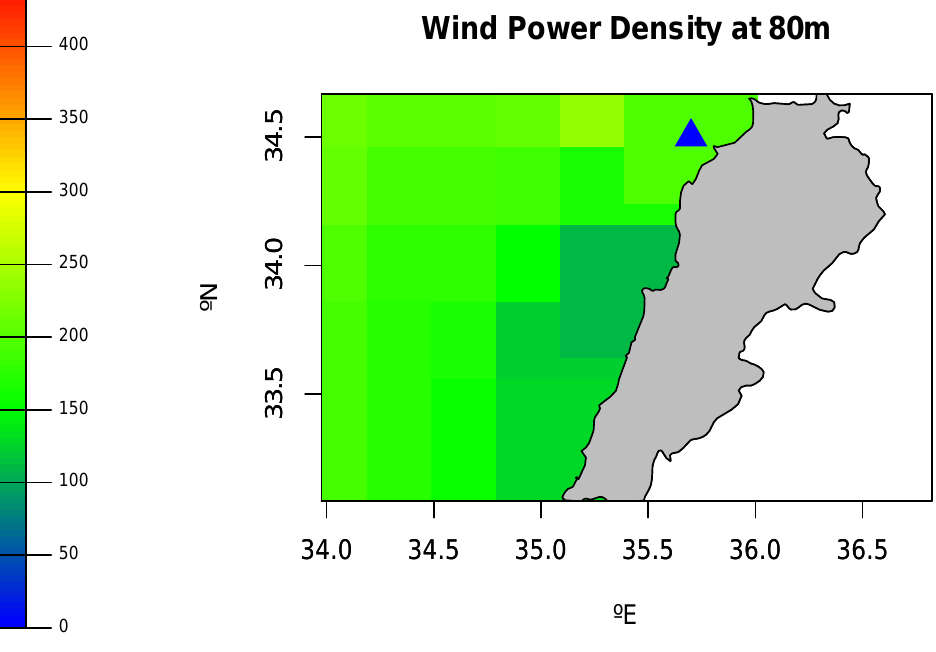
Figure 7. wind power density at 80 masl WPD 80 . Overall average. The blue triangle represents the pixel centered at coordinates [35 o E, 34.5 o